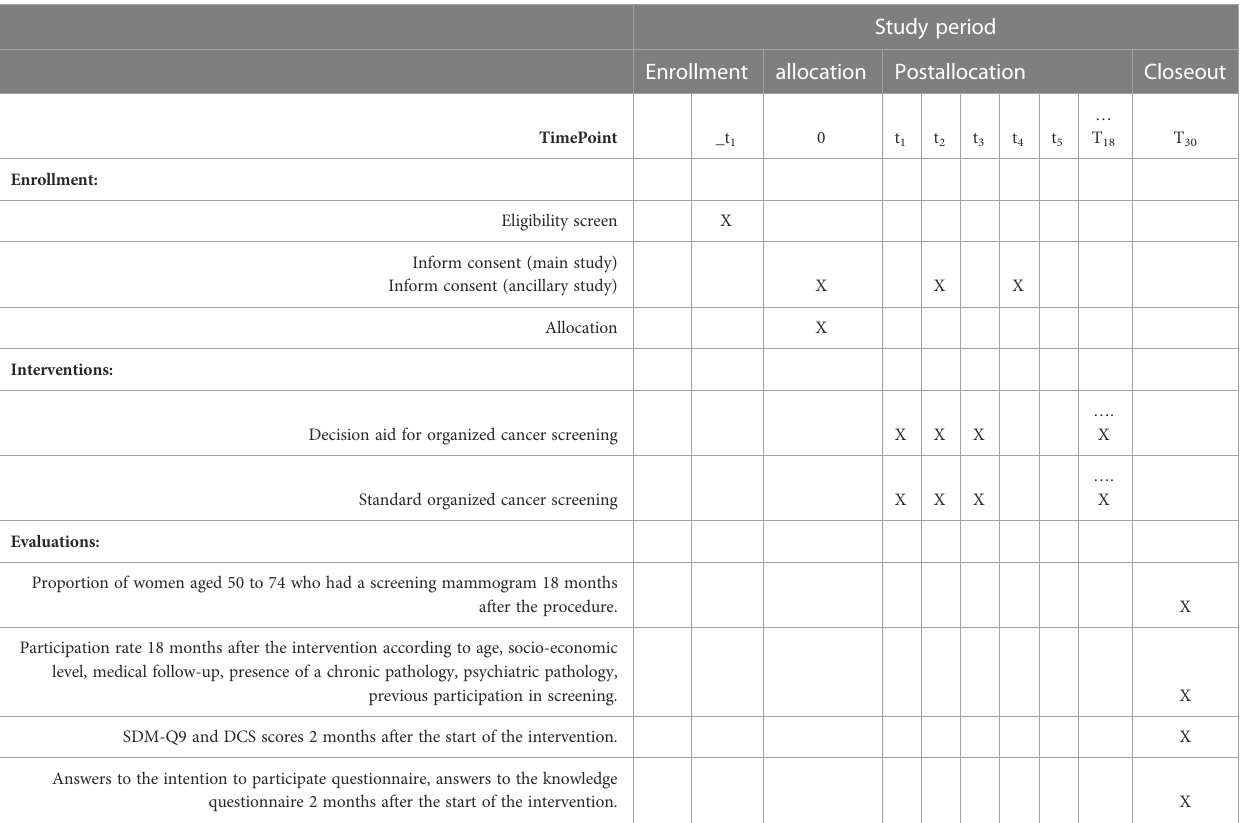
TABLE 2 Time schedule for enrolment, intervention and